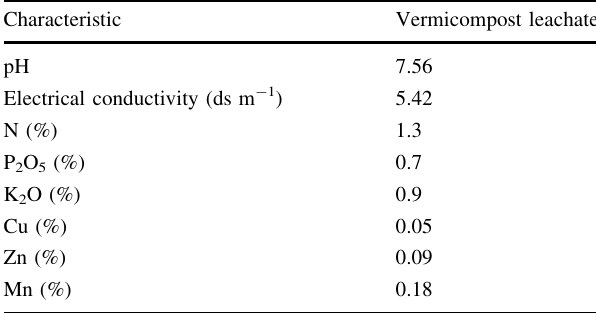
Table 1 Characteristic of vermicompost leachate obtained from cattle